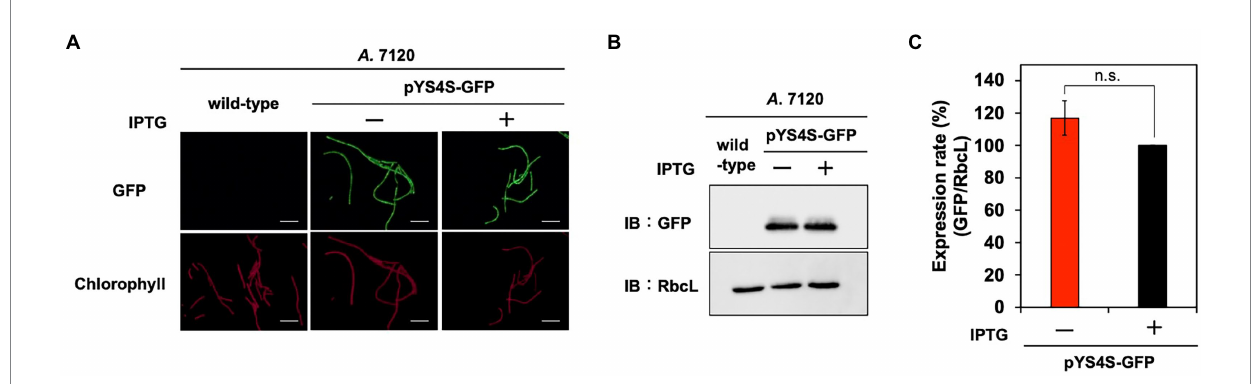
FIGURE 6 Utilization of pYS in A . 7120. GFP expression levels in pYS4S-GFP transconjugants were analyzed with (+) and without ( − ) 1 mM IPTG. (A) Fluorescence microscopy images. The GFP and chlorophyll images are shown. White bar: 20 μ m. (B) Western blotting analysis. The protein extracts obtained from A . 7120 cells were subjected to SDS-PAGE and analyzed by western blotting using antibodies against GFP and control RbcL. (C) Comparison of GFP signals. The GFP signals obtained from western blotting analysis were normalized to those of the RbcL signal, and the ratio of the GFP signal in the presence of IPTG was set to 100. Bars represent the mean ± SEM ( n =